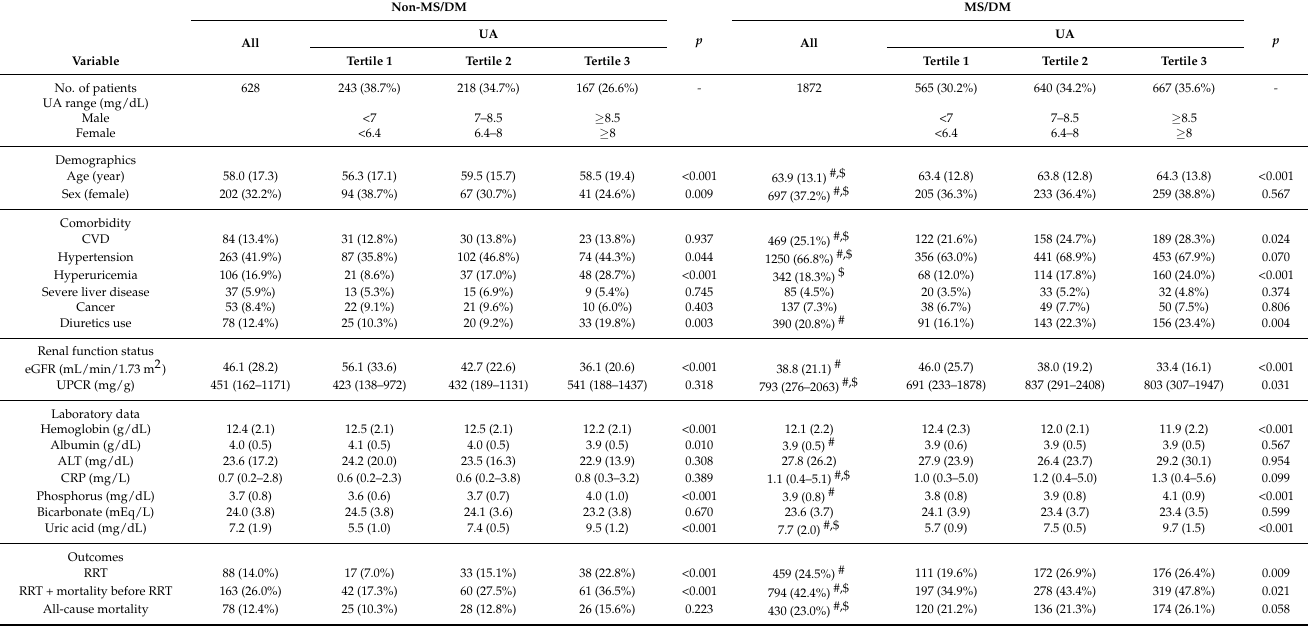
Table 1. Baseline characteristics of CKD stage 1–4 patients divided by MS/DM and uric acid